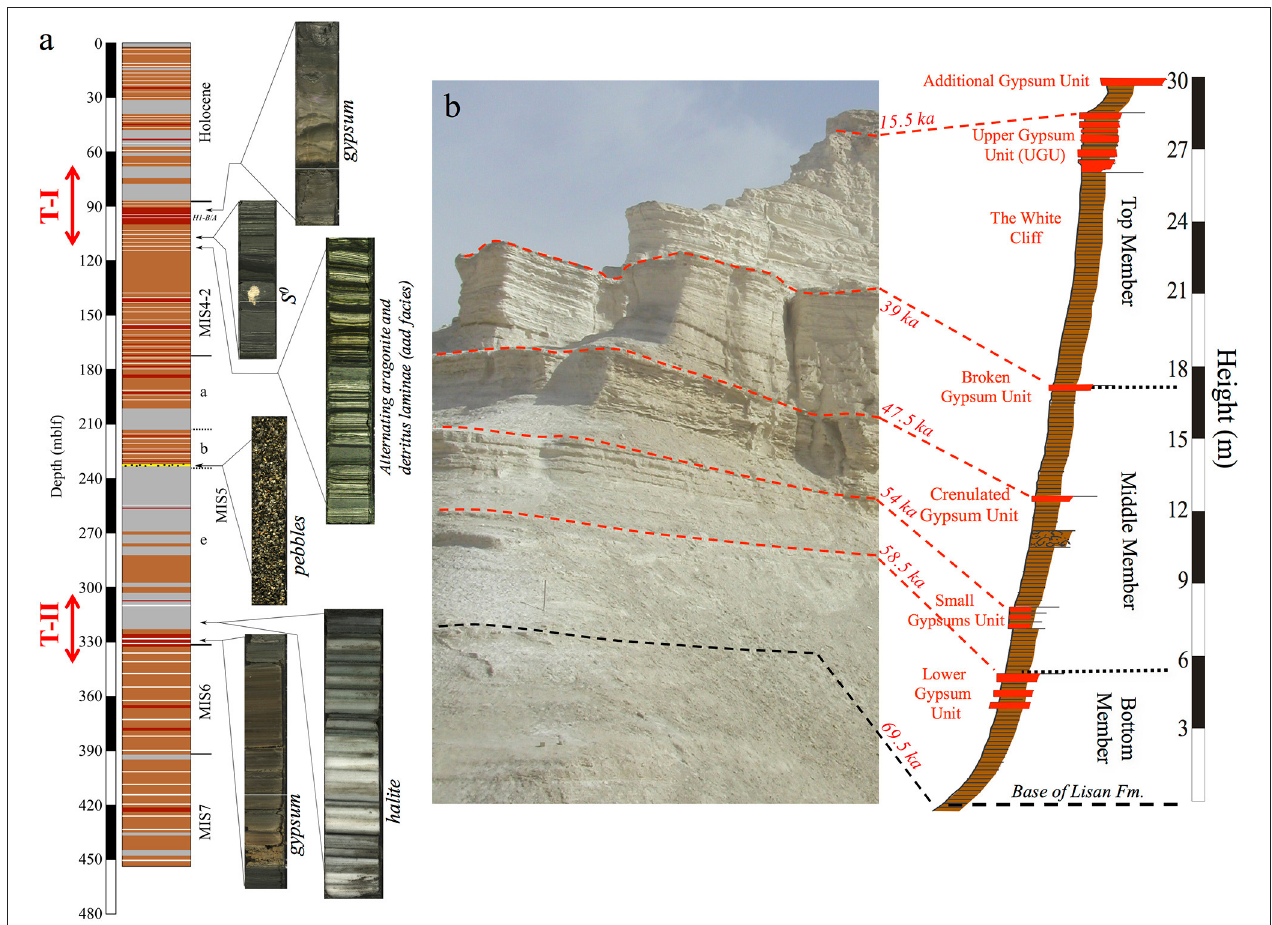
FIGURE 2 | (a) Generalized columnar section of the Dead Sea Deep Drilling Project (DSDDP) core, (b) Masada M1 section. Core photos of several sediment facies are presented in (a) . Legend for columnar section: gray, halite; red, gypsum; white stripes, aad facies; brown, marl; yellow layer (at 234 mblf), pebble layer. The timing of Termination –II and –I is marked by red arrow left of the columnar section. Ages of marker layers in (b) are from Torfstein et al. (2013a). Note that the Masada M1 section of the Lisan Formation, corresponds to depths of ∼ 177–90 mblf in the DSDDP core.